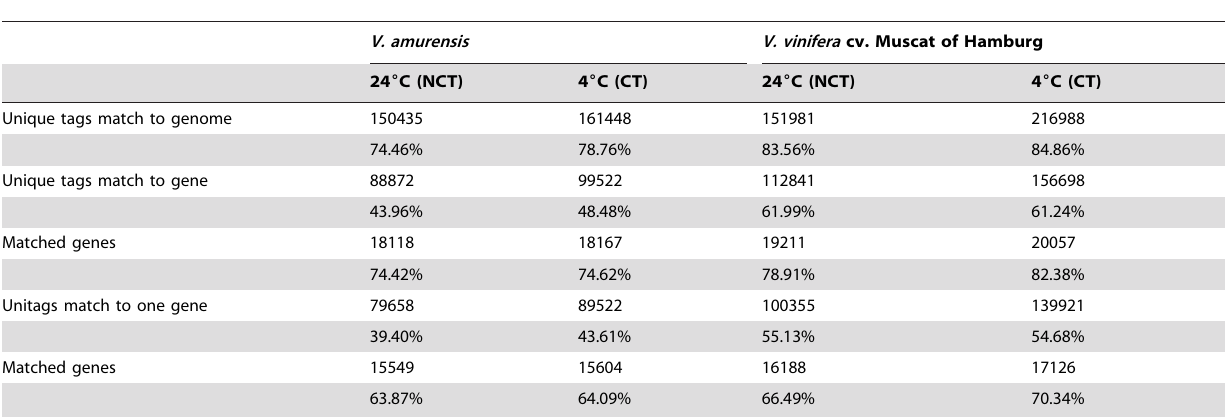
Table 2. Annotation of V. amurensis and V. vinifera cv. Muscat of Hamburg tags against the ‘Pinot Noir’ genomic sequences.